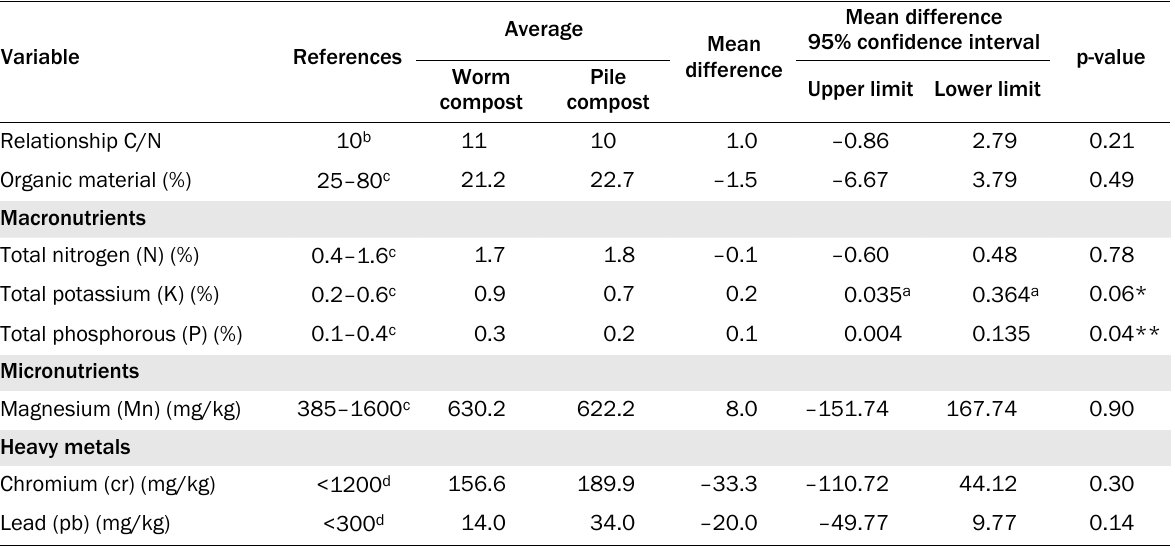
Table 1. Nutrients and Heavy Metals Found at Five Trial Sites Using Two Methods of Urban Organic Waste Composting in Chiapas,